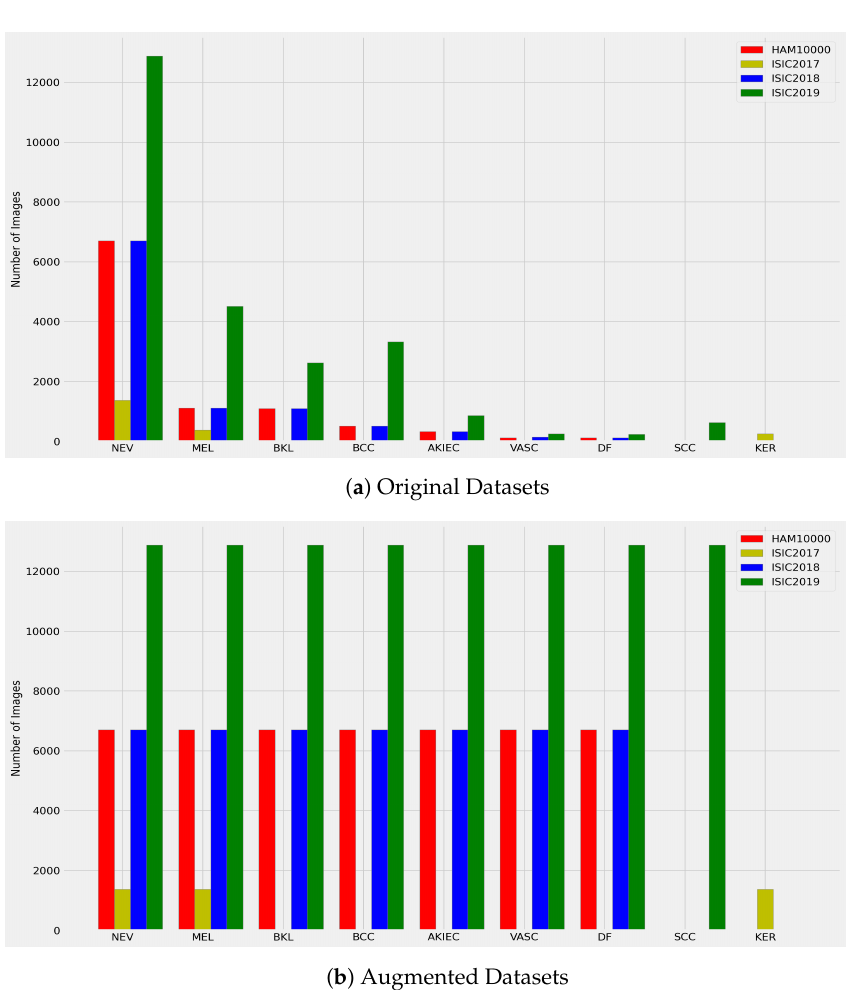
Figure 3. The original datasets without and with the augmentation technique.